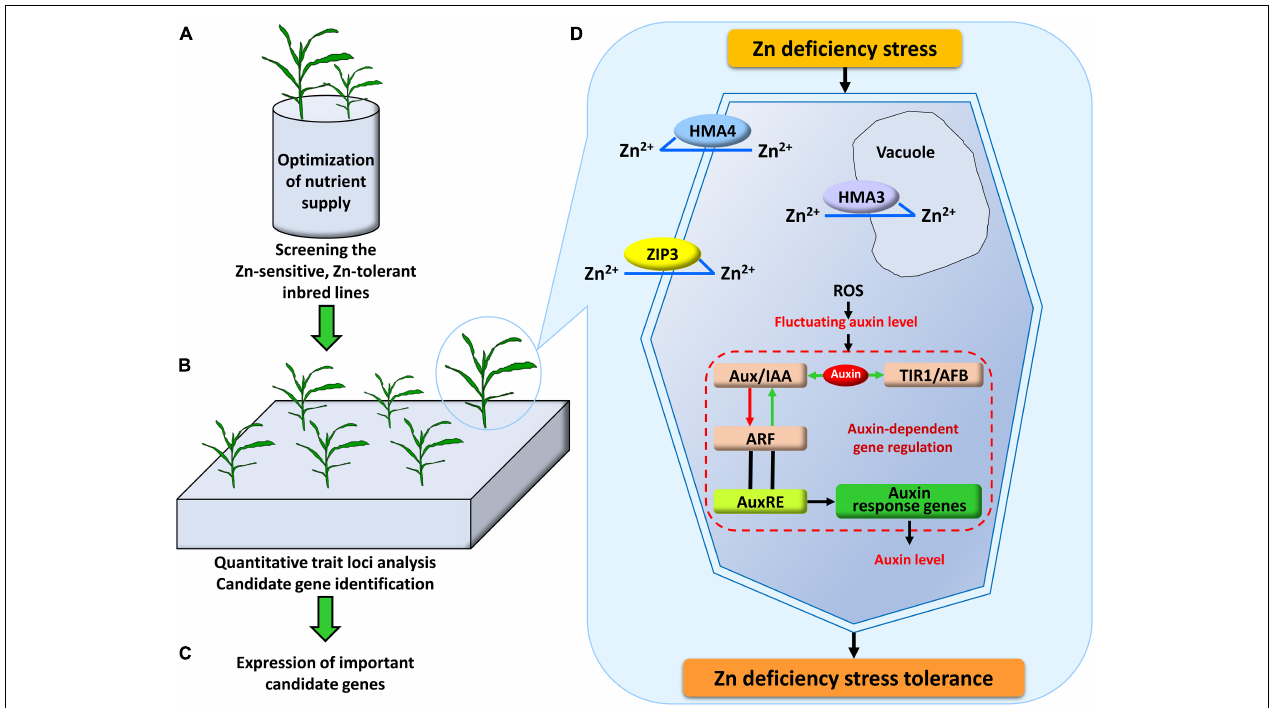
FIGURE 4 | Systematic research design and schematic model for the mechanism of Zn deficiency tolerance in plants. (A) The nutrient solution supply was optimized by adjusting the NH 4 + /NO 3 − ratio and the supply level of other metal ions. On this basis, the most tolerant and the most sensitive parents under Zn deficiency stress were screened out. (B) Quantitative trait loci associated with Zn deficiency tolerance were detected in the linkage population derived from the parents screened out from (A) , and candidate genes were identified within these loci. (C) Based on the results of physiological experiments and the candidate genes identified by the QTL analysis, the expression of eight ZIP genes ( ZmZIP1 - 8 ) was analyzed under -Zn and CK conditions. (D) In the mechanisms of Zn deficiency stress tolerance, the important genes which may be involved in the uptake of Zn 2 + from the soil to roots and preferential distribution to shoot ( ZmZIP3 ), sequestering Zn 2 + into vacuole ( ZmHMA3 ), translocating Zn 2 + from root to shoot ( ZmHMA4 ), probably participate in the uptake, transport and redistribution of Zn. In addition, the gene that may repress transcription of ARF plays an essential role in the auxin-dependent gene regulation ( ZmIAA17